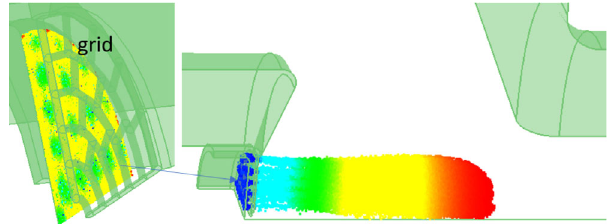
FIG. 4. Beam distribution at the time of emission from the cathode and βγ beam distribution in the middle of the injector